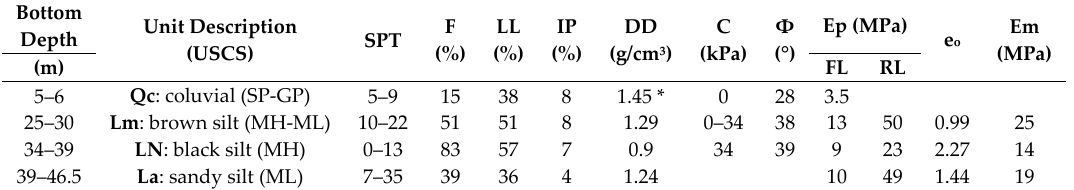
Table 3. Geotechnical units filling the crater and geotechnical